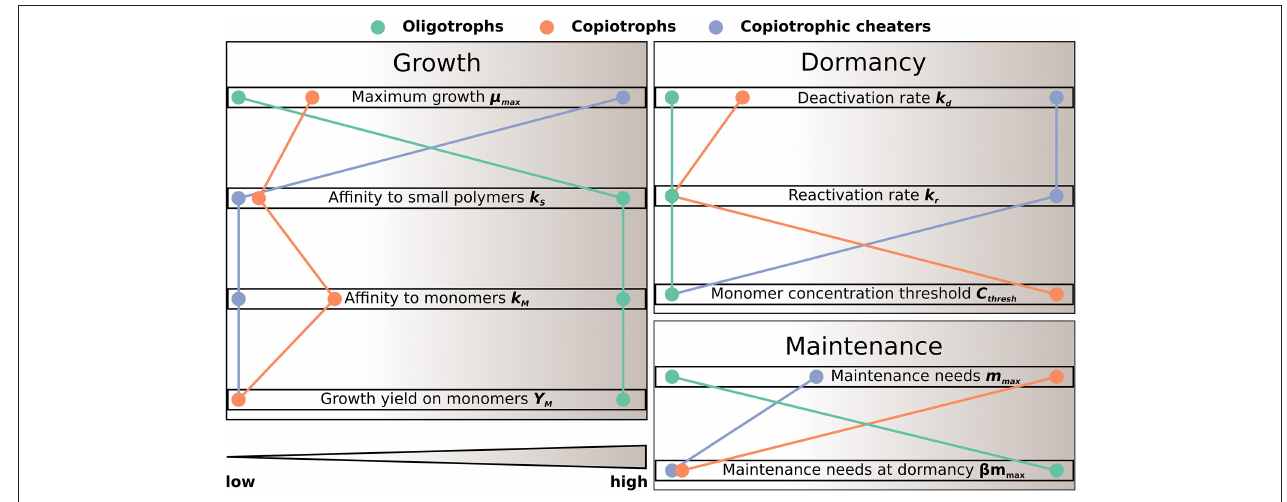
FIGURE 2 | Schematic illustration of trade-off in functional microbial traits as implemented in SpatC (see also Table 1 ).